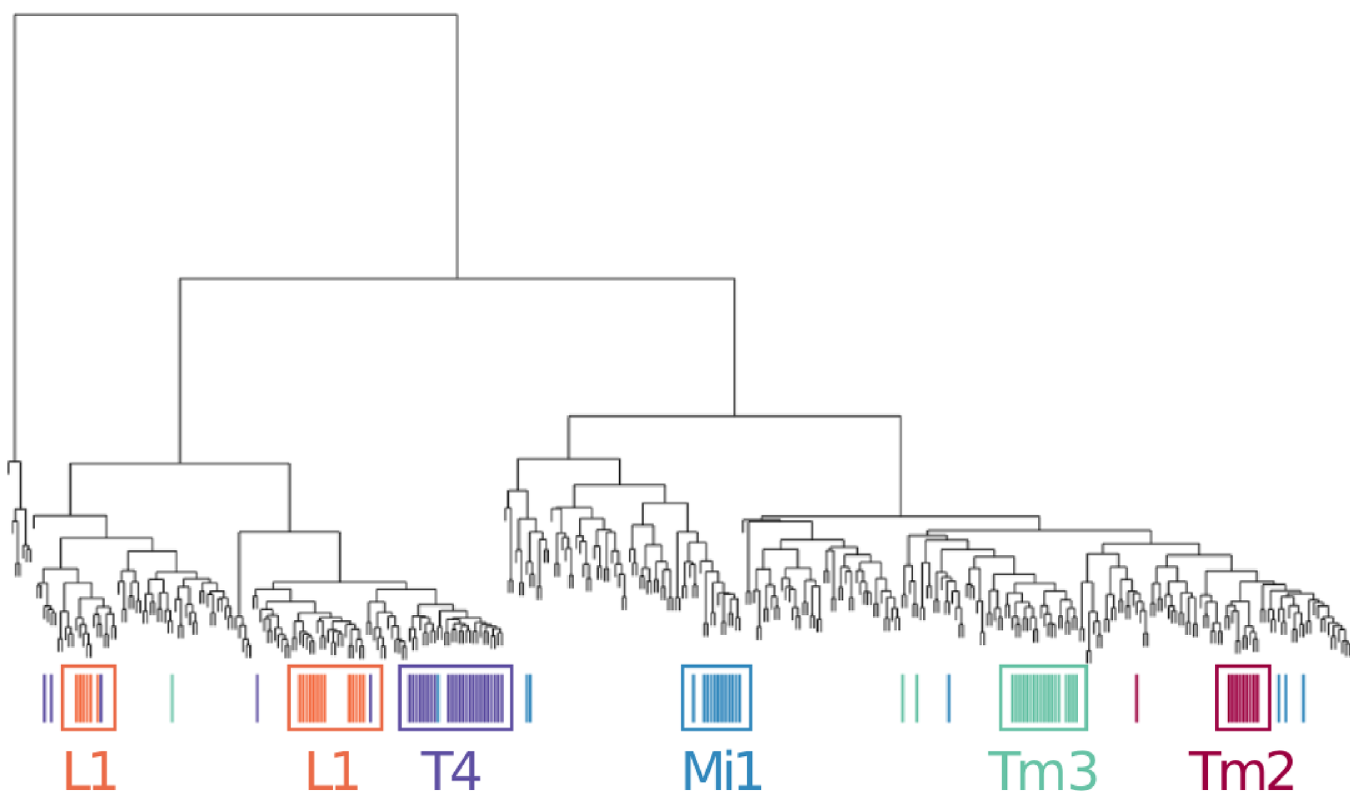
Fig 9. The HCT of Dataset1 . Each leaf corresponds to a neuronstructure, and those from the top 5 largest classes (class “Tangential” excluded)are marked (color